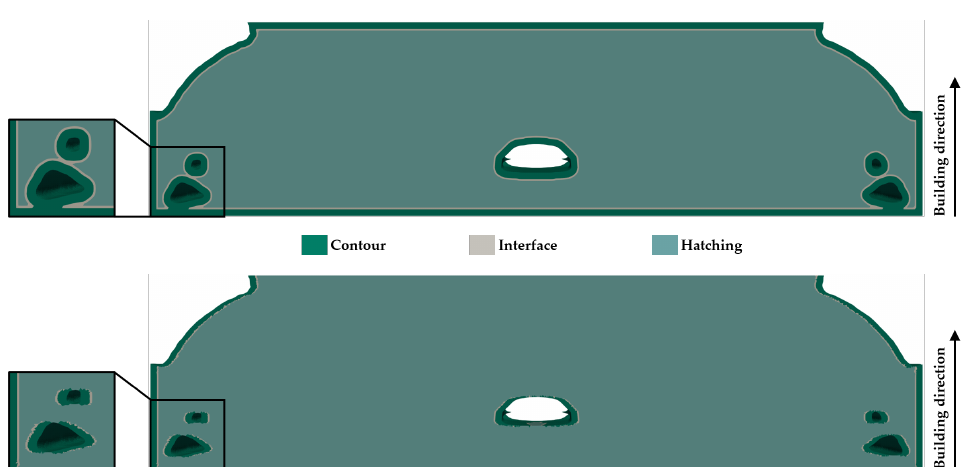
Figure 7. Meshed intermediate results, including divided areas: Unfiltered ( top ) and filtered ( bottom ).